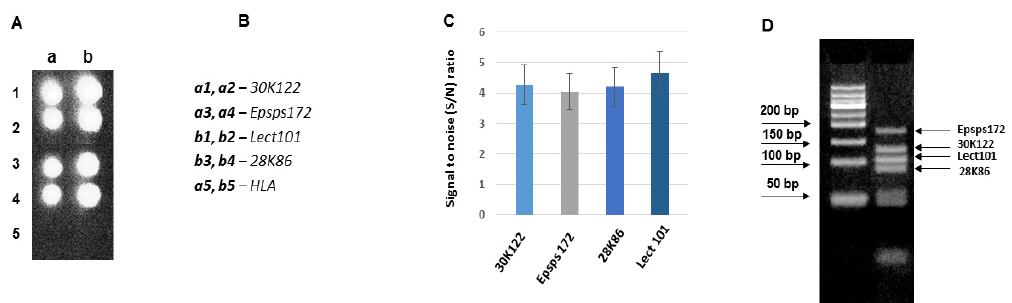
Figure 8. Hybridization of asymmetric multiplex PCR (N4) products with the probes Lect101, epsps172, 28K86 and 30K122 on a biochip. ( A ) Hybridization image ( a , b ) designations of the columns for the probe arrangement; ( B ) The arrangement of the probes on the biochips; ( C ) Analysis of hybridization; the hybridization signal intensities estimated as signal to noise (S/N) ratio. ( D ) Agarose gel electrophoresis of asymmetric PCR products. Total DNA per hybridization is 1340 ng, the amount of fluorescent dye Cy3 is 18 pmol.